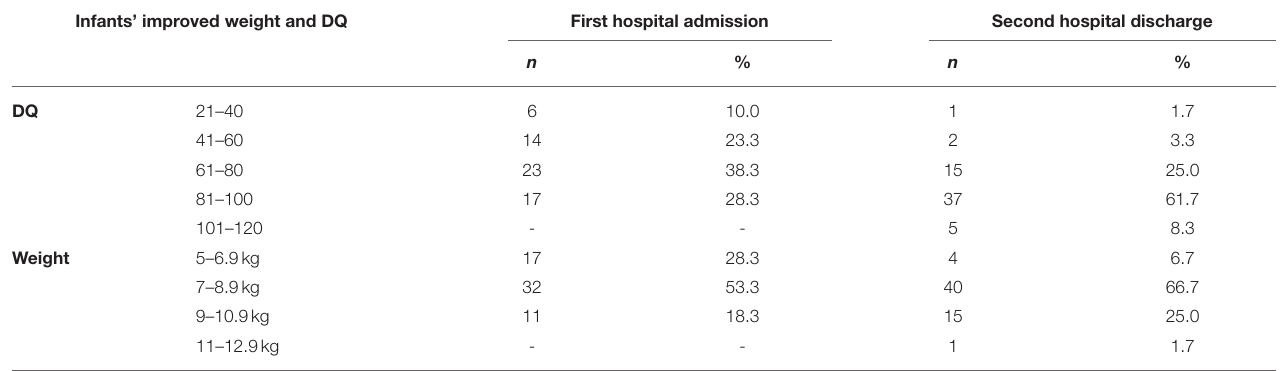
TABLE 2 | Improved weight and DQ of infants during two hospitalizations ( n = 60). Infants’ improved weight and DQ